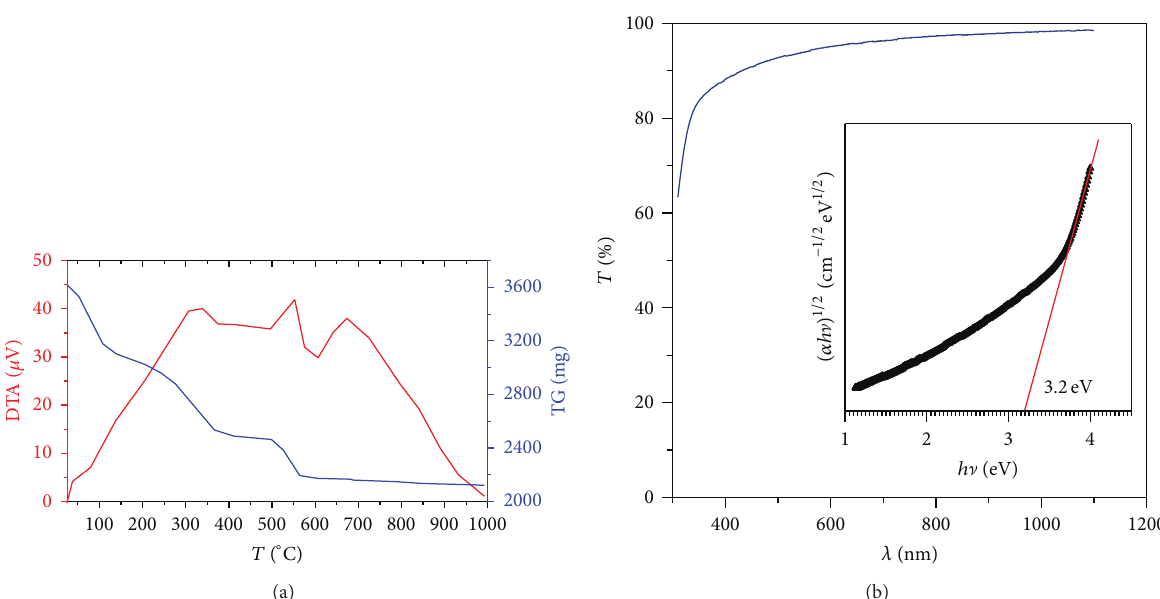
Figure 1: (a) TG/DTA measurement curves on TiO 2 sol and (b) UV-transmittance measurement of TiO 2 film grown on glass. The inset shows Tauc plot to determine the band gap of the present